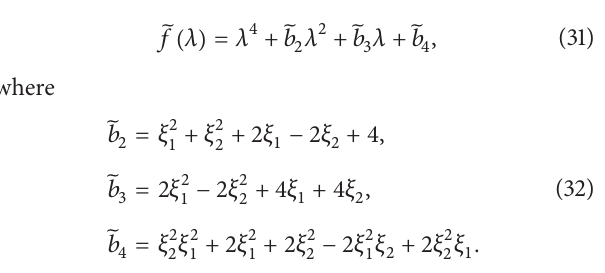
It yields that 𝑏 2 = 4 , 𝑏 1 = 𝑏 3 = 𝑏 4 = 0 and the Jacobian matrix (4) has the eigenvalues 𝜆 1,2 = 0 , 𝜆 3,4 = ±2𝑖